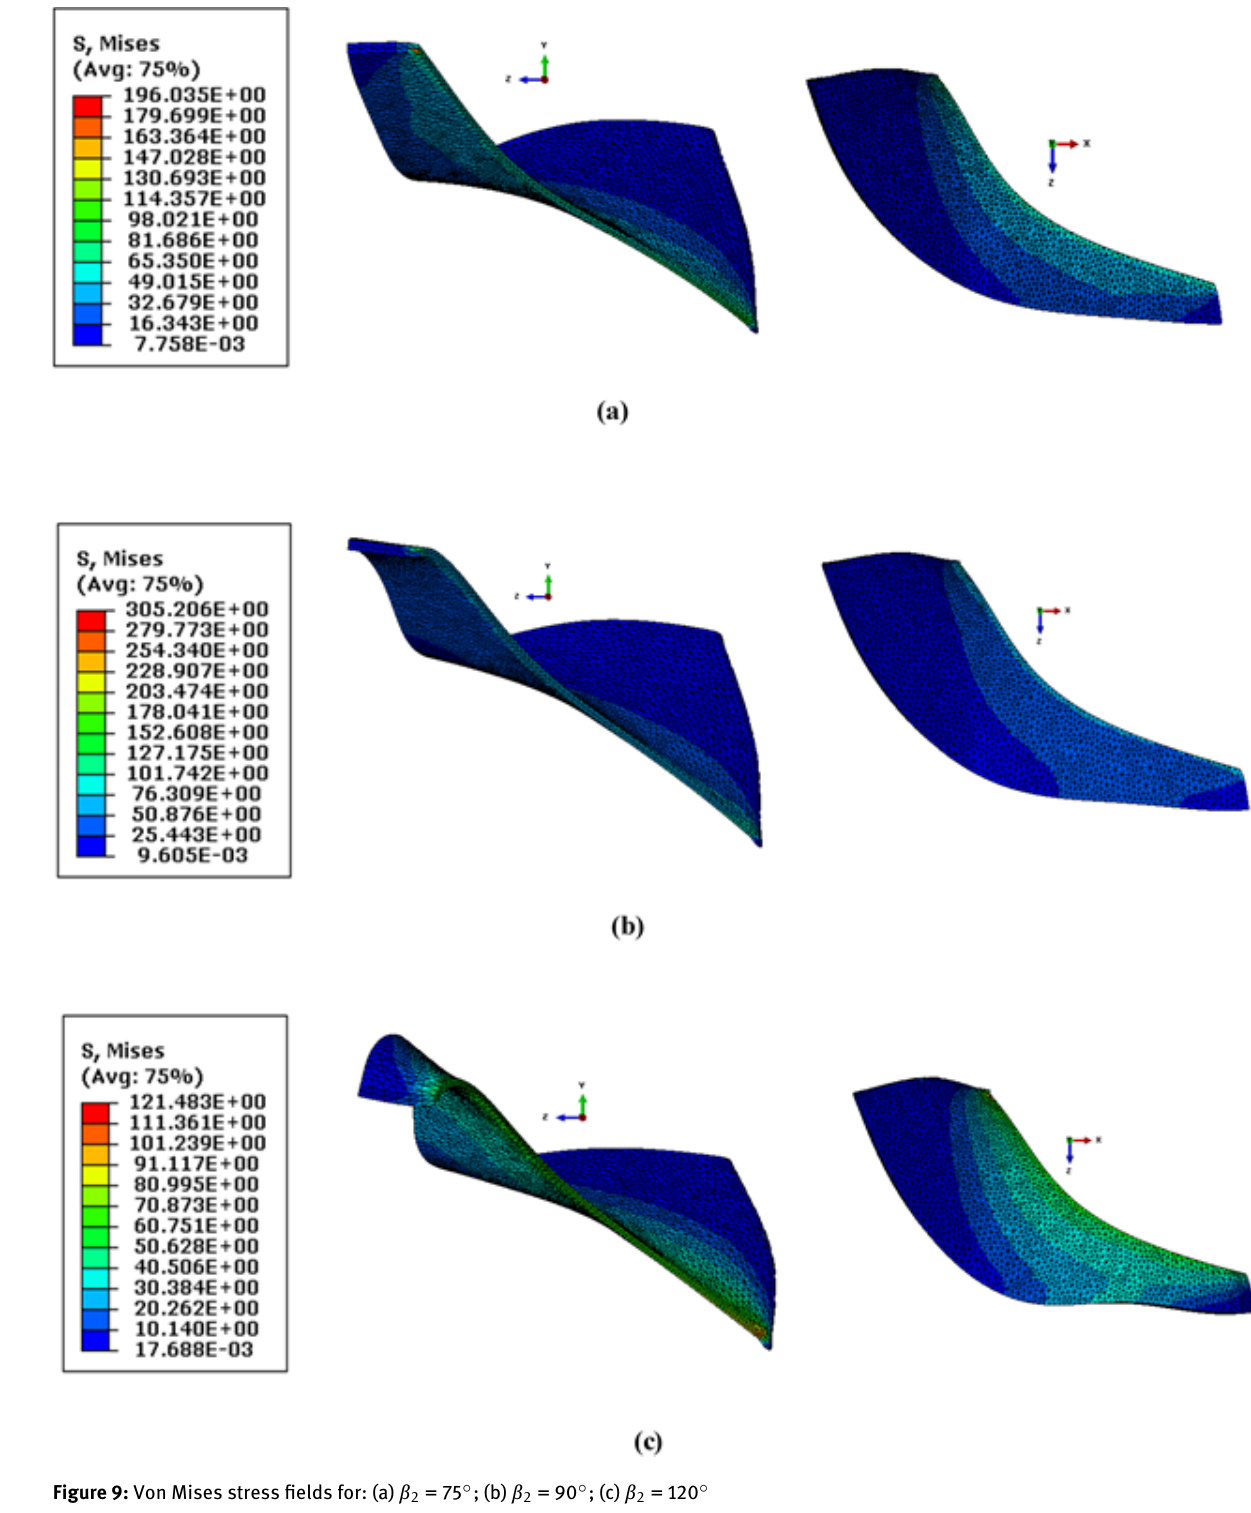
Figure 9: Von Mises stress fields for: (a) β 2 = 75 ∘ ; (b) β 2 = 90 ∘ ; (c) β 2 = 120